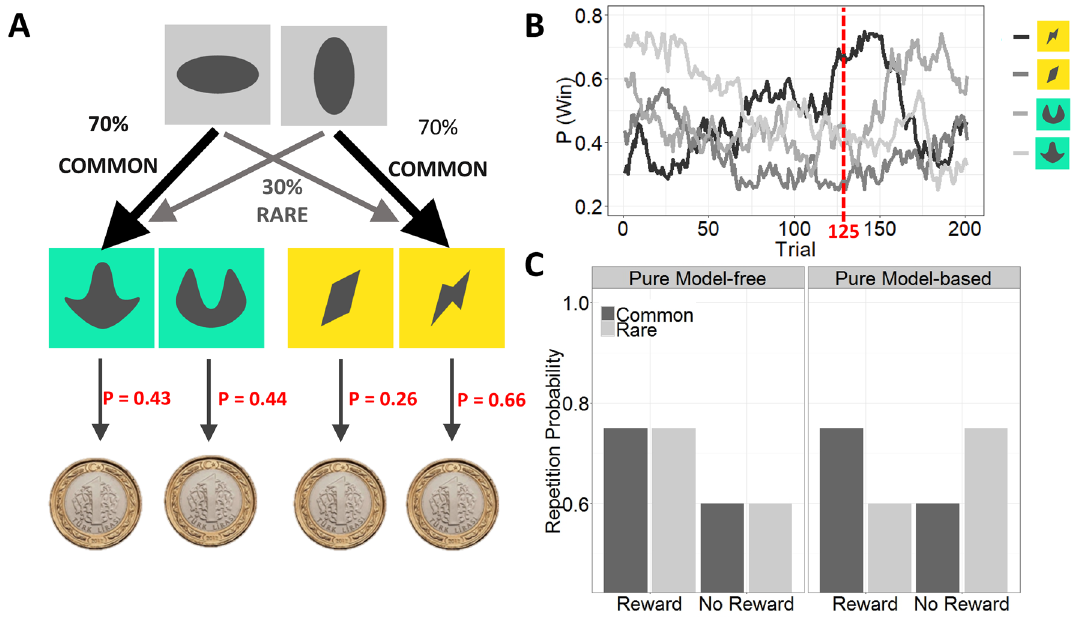
Figure 4. Description of the task. ( A ) One trial of the two-step task. ( B ) Probabilities for 2nd stage outcomes. The win probability for each of the four 2nd stage stimuli varied over time according to a slow and independent random walk (red: example for reward probabilities at trial 125). ( C ) Expected choice behavior for MF vs. MB behavior. The distinction between model-based and model-free performance depends on the use of the transition probability. A purely model-free learner shows a main effect of outcome (Reward vs. No Reward) on 1st stage repetition probability whereas a purely model-based learner shows an interaction between transition frequency (Common vs. Rare) and outcome (Reward vs. No Reward) on 1st stage repetition